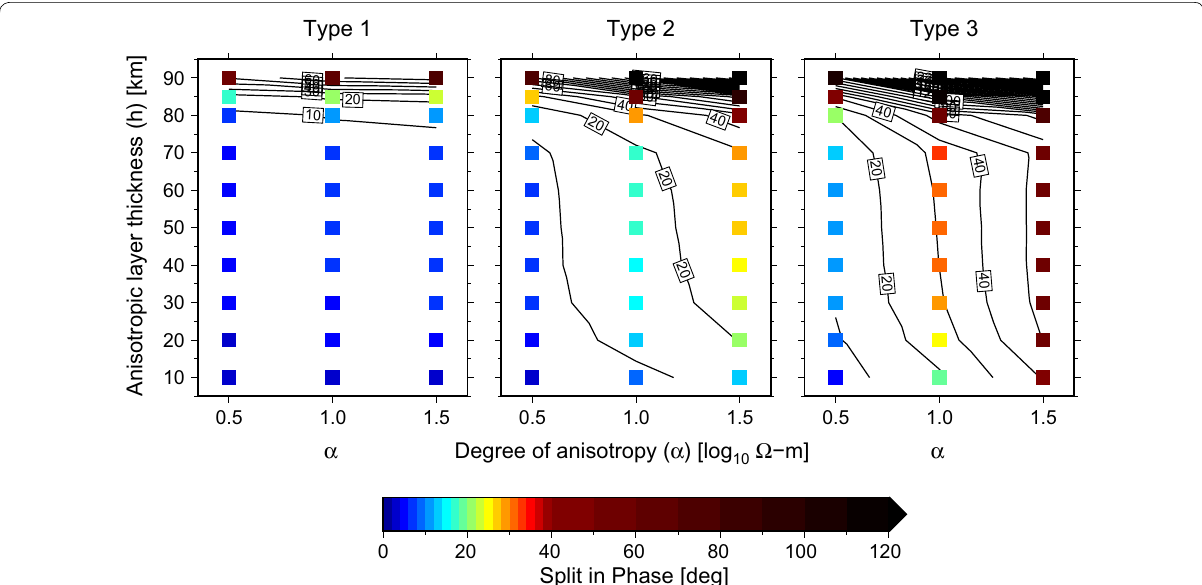
Fig. 3 Maps of cumulative phase splitting between off-diagonal ( yx and xy ) elements at 8 periods from 640 to 7680 s as a function of the aniso- tropic layer thickness ( h ) and the degree of anisotropy ( α